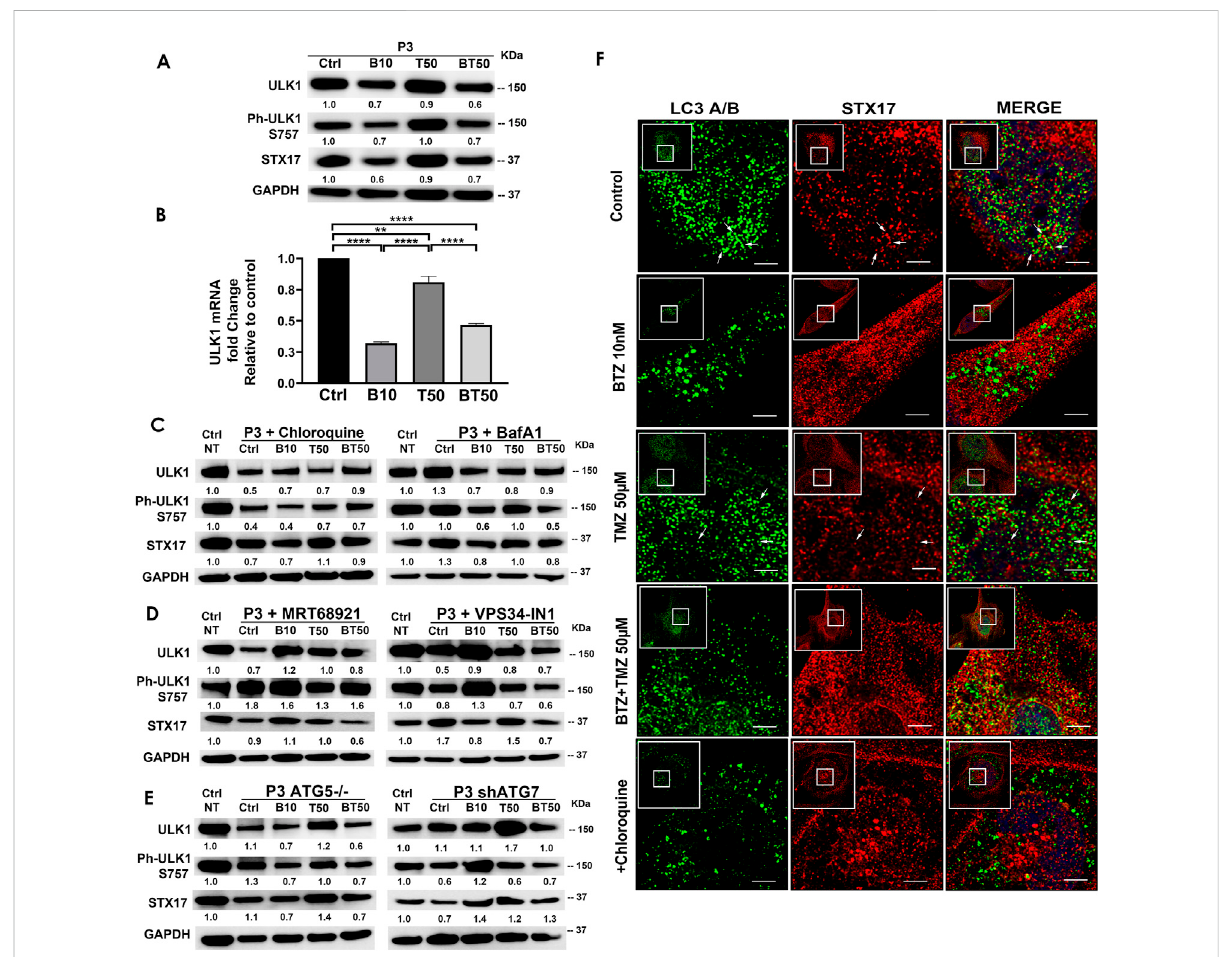
FIGURE 4 BTZ abrogates autophagic fl ux by blocking autophagosome-lysosome fusion. (A) Western blot of the indicated proteins in lysates of wild type P3 cells treated with 10 nM BTZ (B10), 50 μ M TMZ (T50) or both (BT50) (B) ULK1 mRNA fold change after indicated treatments in P3 cells. (C,D) Western blot of the indicated proteins in lysates of P3 cells treated with 10 nM BTZ (B10), 50 μ M TMZ (T50) or both (BT50) or in a combination with autophagyinhibitors(chloroquine, BafA1, MRT68921orVPS34-IN1) (E) WesternblotoftheindicatedproteinsinlysatesofP3cellslacking ATG5 ( ATG5 − / − )and ATG7 (shATG7). GAPDH wasused as aloadingcontrol andfor normalizingdensitometrymeasurements oftheblots. GAPDHblotsinC isfromthesamesamples/experimentsusedinFigure2.CtrlNT=non-treatedcontrolcells. (F) ConfocalmicroscopyofP3cellsco-stainedforLC3A/ B and STX17, subsequently treated as indicated, in the presence or absence of CQ, scale bar 5 μ m; for the zoomed part of the image from the image shown in the white square. White arrows are indicating the STX17 and LC3A/B